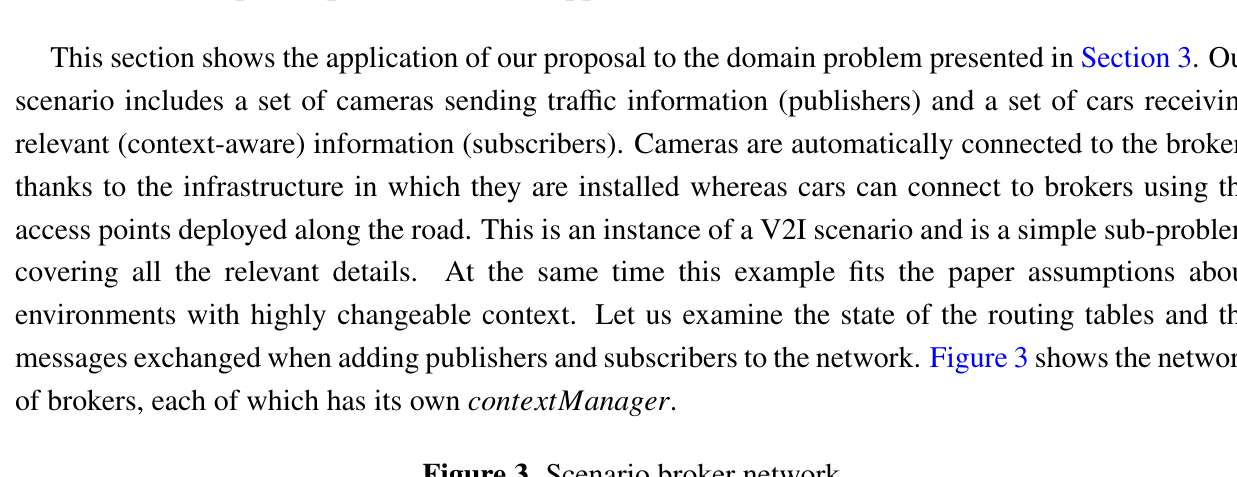
Figure 3. Scenario broker